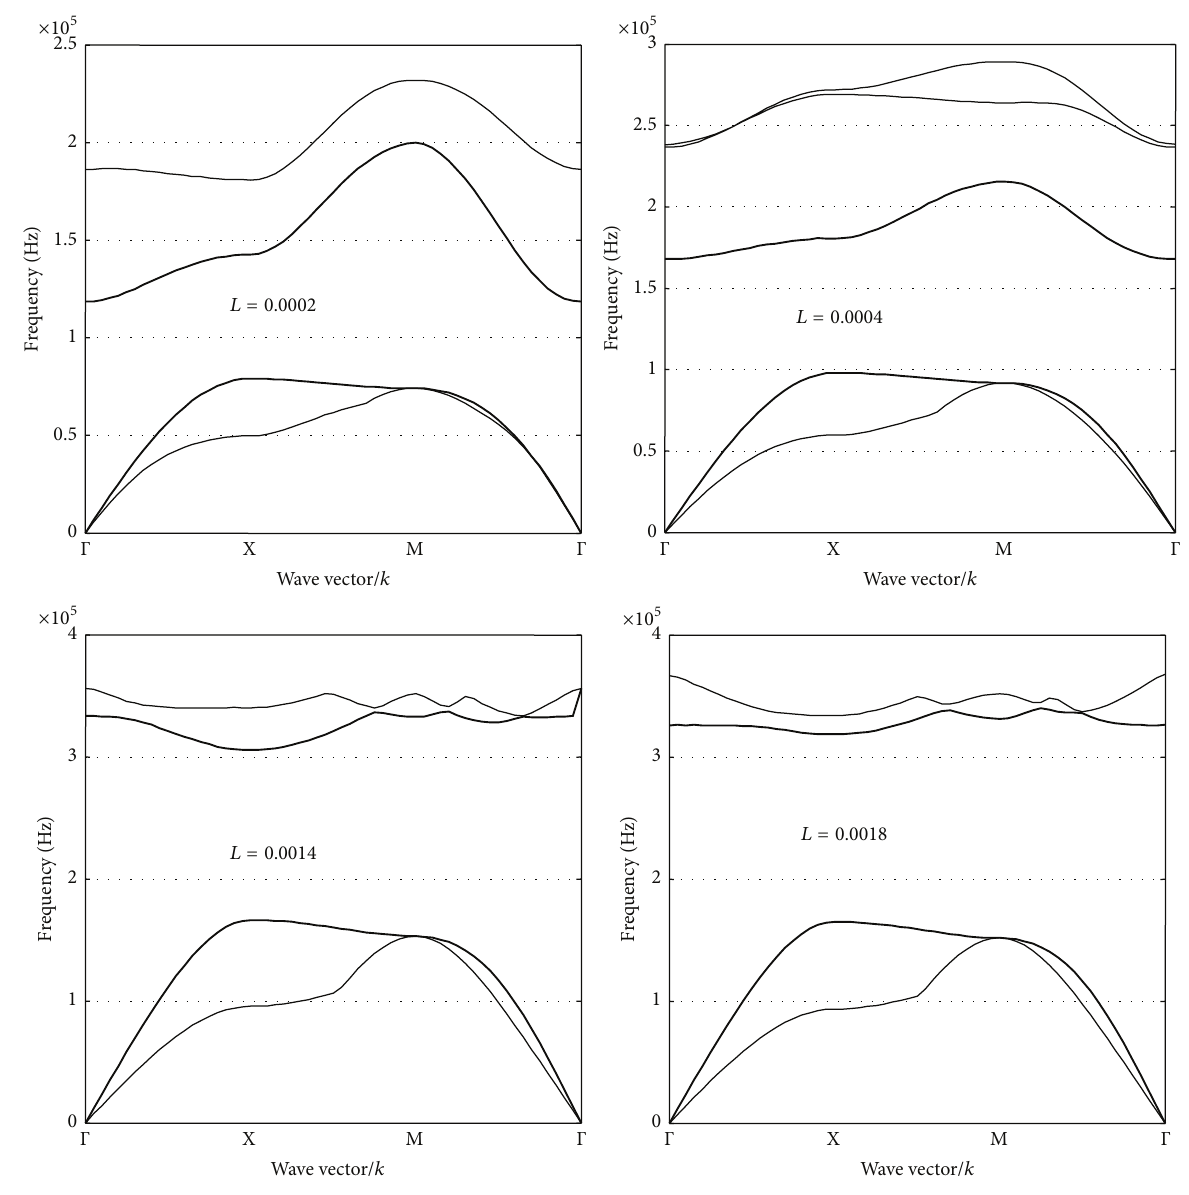
Figure 6: The dispersion curves of the phononic crystals with different length of connection plates structures.